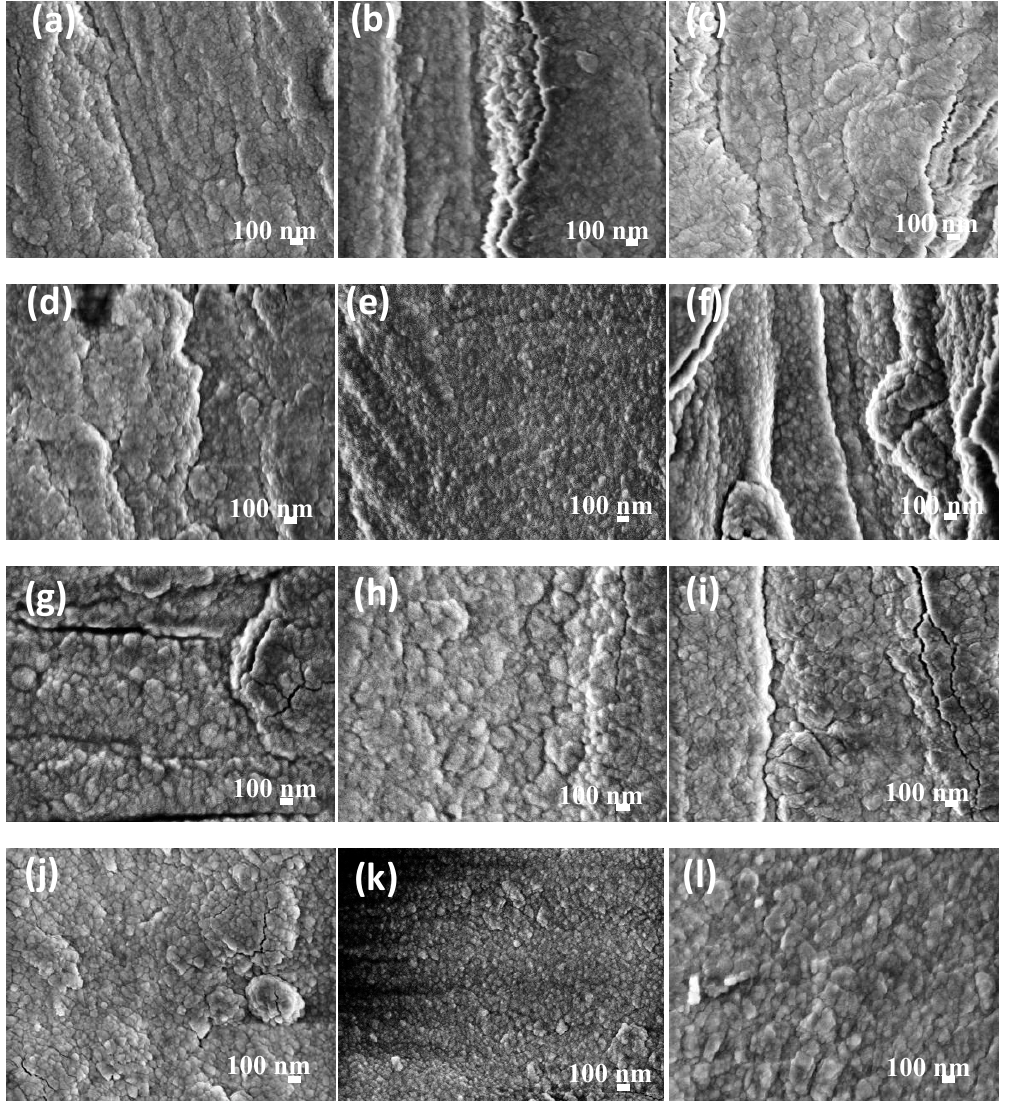
Figure 3. High Resolution Scanning Electron Microscopy (HRSEM) images of La coatings on AA6061 aluminum alloy substrates: ( a ) P 60 T 80 t 25 , ( b ) P 60 T 80 t 40 , ( c ) P 60 T 80 t 60 , ( d ) P 60 T 200 t 25 , ( e ) P 60 T 200 t 40 , ( f ) P 60 T 200 t 60 , ( g ) P 80 T 80 t 25 , ( h ) P 80 T 80 t 40 , ( i ) P 80 T 80 t 60 , ( j ) P 80 T 200 t 25 , ( k ) P 80 T 200 t 40 , and ( l ) P 80 T 200 t 60 .